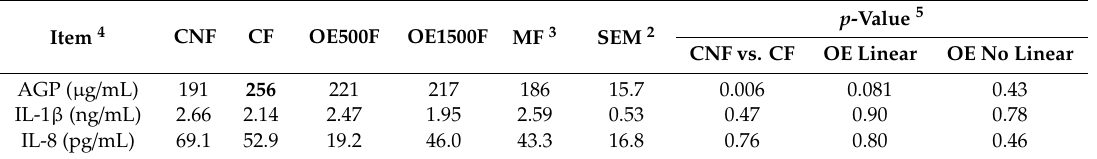
Table 5. E ff ect of a short-term (15.5 h) fasting period and experimental diets on AGP, IL-1 β and IL-8 concentration in chicken plasma at 15 d of age 1 .